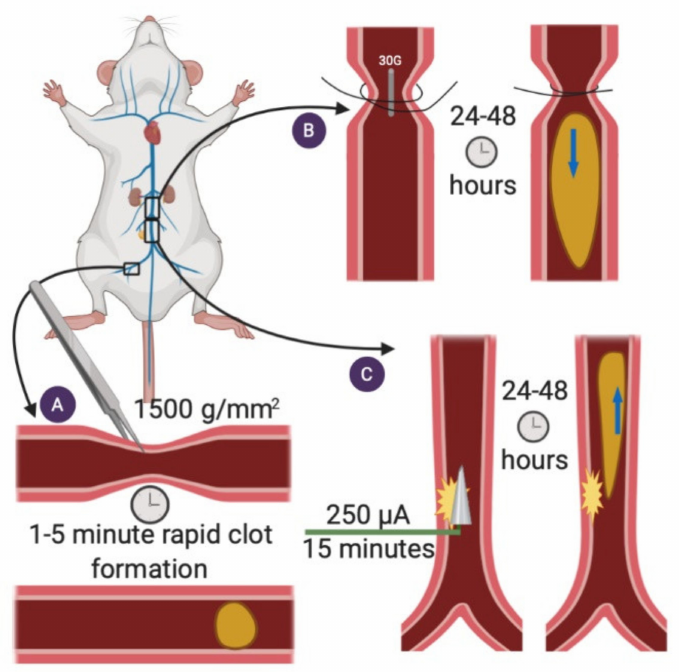
Figure 1. APS models of venous thrombosis. ( A ) Femoral vein pinch. A pinch injury is applied to the femoral vein, and rapid clot formation occurs 1–5 min following the injury [14]. ( B ), Stenosis. A ligature is placed around the IVC to achieve 90% occlusion, the spacer is removed and a thrombus forms in opposition to blood flow [15]. ( C ) Electrolytic IVC. Current is applied to a needle inserted into the IVC for 15 min. A thrombus grows in the direction of blood flow